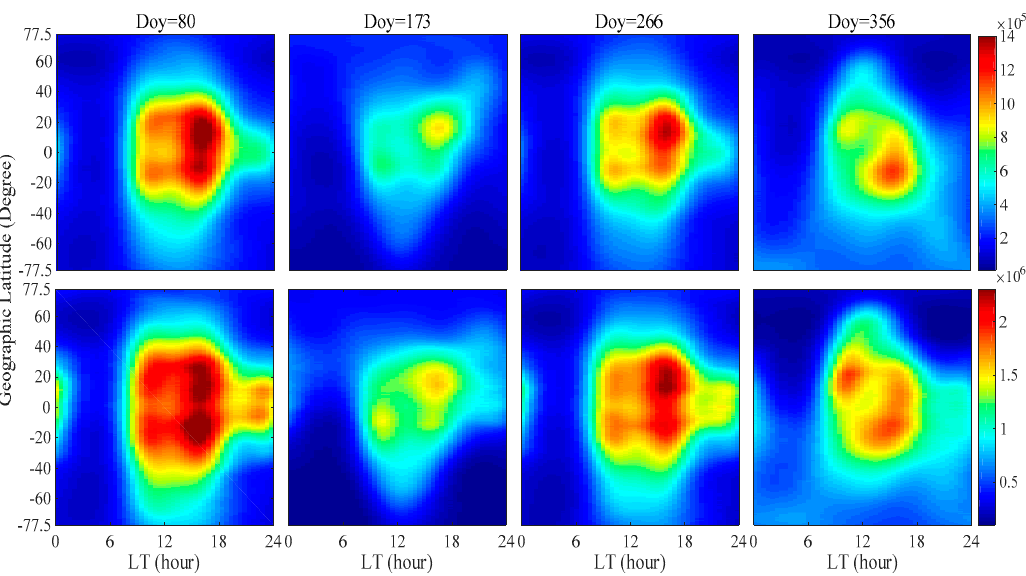
Figure 12. Longitudinal mean variations of NPPDM as functions of latitude and local time under both low solar activity (upper panel) and high solar activity (lower panel) (cm − 3 ). Latitude versus longitude distributions of NmF2 at 02 LT and 14 LT produced by NPPDM at the September equinox are displayed in Figures 13 and 14, corresponding to low (F10.7 = 80 sfu) and high (F10.7 = 150 sfu) solar activity, respectively. We can see from the figures that WN4 patterns are shown at 14LT: the EIA crests are enhanced over West Africa, Southeast Asia, Central Pacific Ocean, and South America. The satellite observations of di ff erent ionospheric parameters, such as total